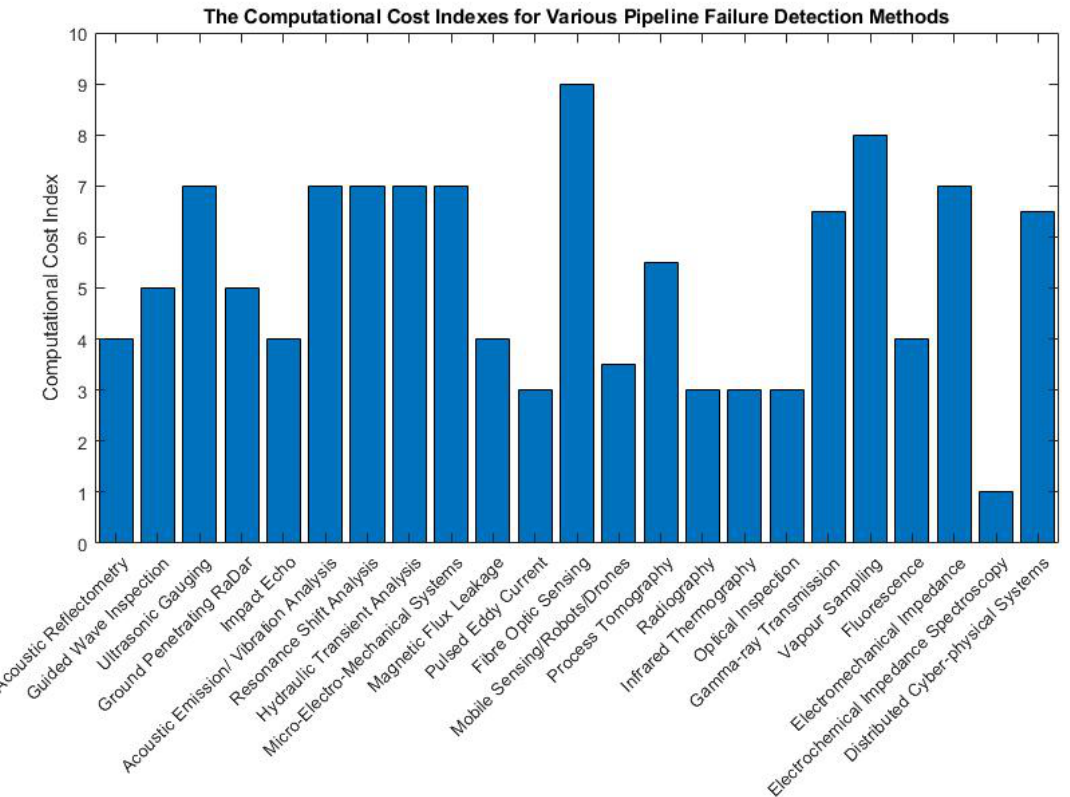
Figure 66. The computational cost indexes for various pipeline failure detection